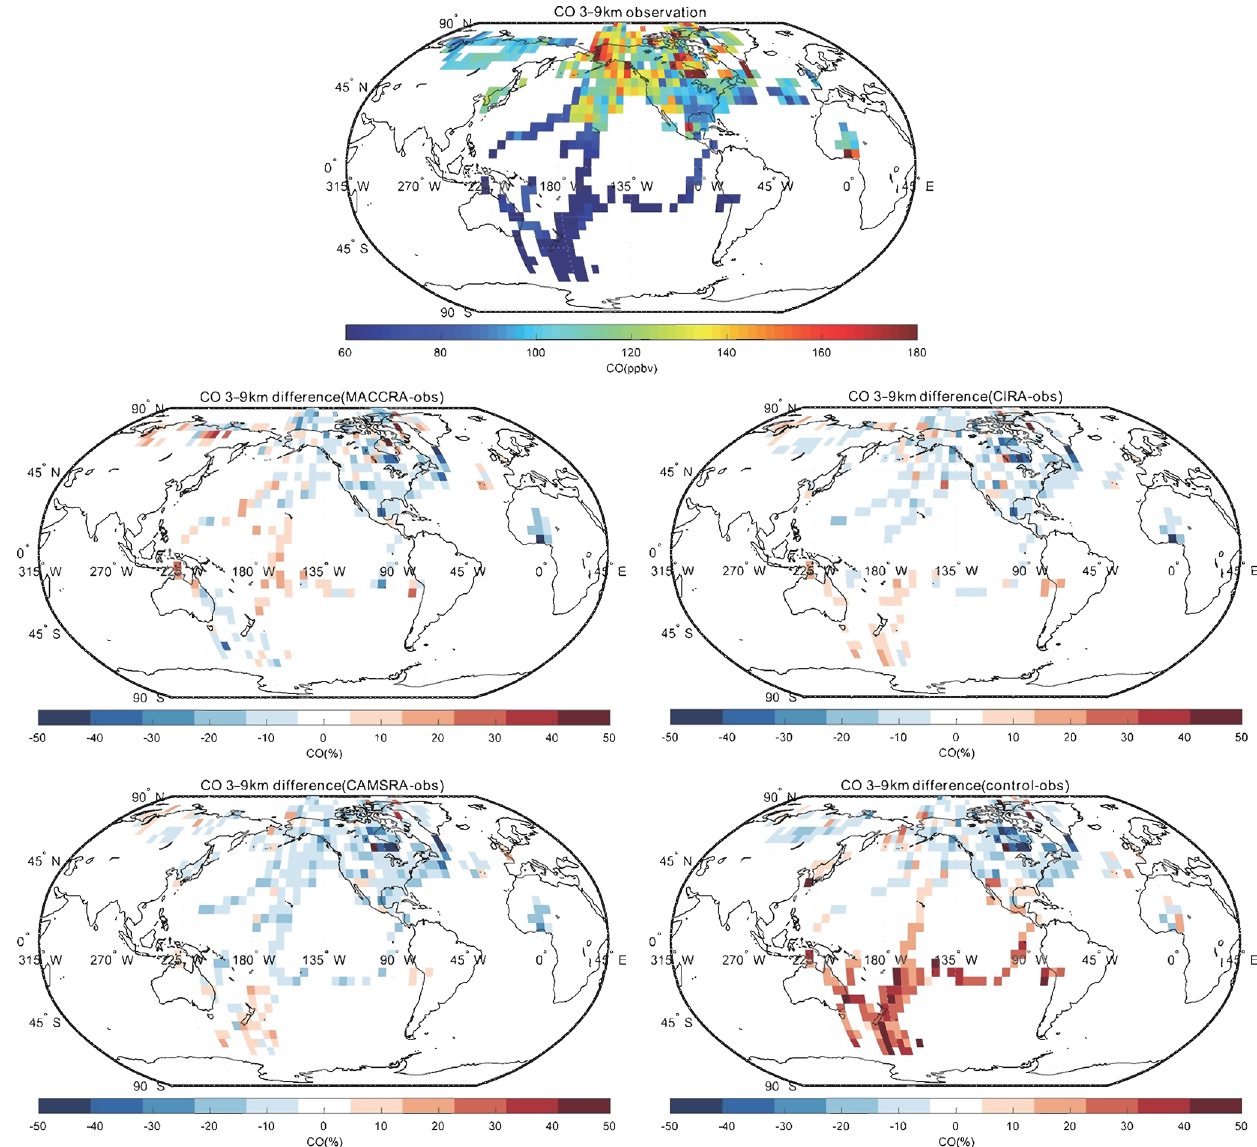
Figure 6. Same as Fig. 5, but for the altitude bin of 3–9km. Table 5. Linear regression of CO between the aircraft campaign observations and the reanalyses. All